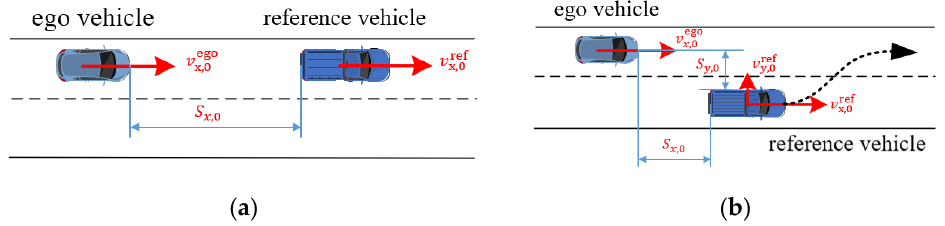
Figure 7. Sketches of the car-following scenario and the cut-in scenario. ( a ) The car-following sce- nario; ( b ) The cut-in scenario.